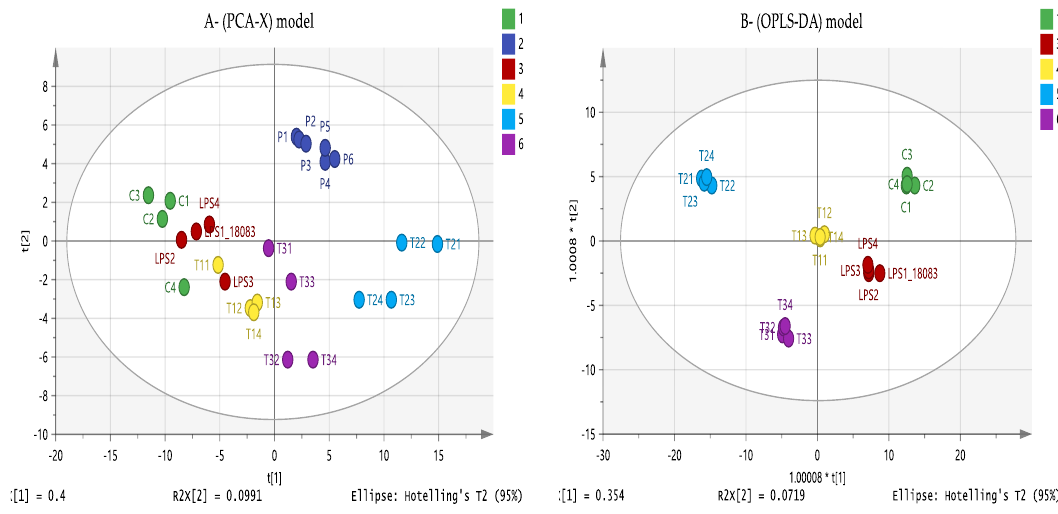
Figure 8. ( A ) Principle component analysis (PCA-X) vs. ( B ) Orthogonal Partial Least Squares Discriminant Analysis (OPLS-DA) score plots of THP-1 cells. The figures show a clear separation between control, pooled and treatment groups based on 314 non-polar metabolites separated on an ACE C4 column ( n = 4). PCA score plot (A) gives the goodness of fit (R 2 X) = 0.571, and the goodness of prediction (Q 2 ) = 0.403. OPLS-DA score plot (B) gives R 2 X = 0.697, R 2 Y = 0.982, Q 2 = 0.628. (C: